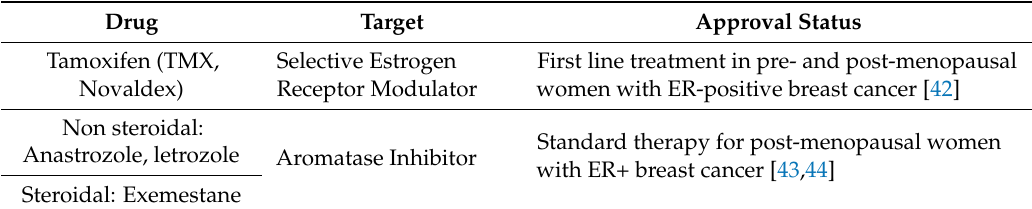
Table 3. Endocrine therapies for Hormone Receptor-Positive Breast Cancer